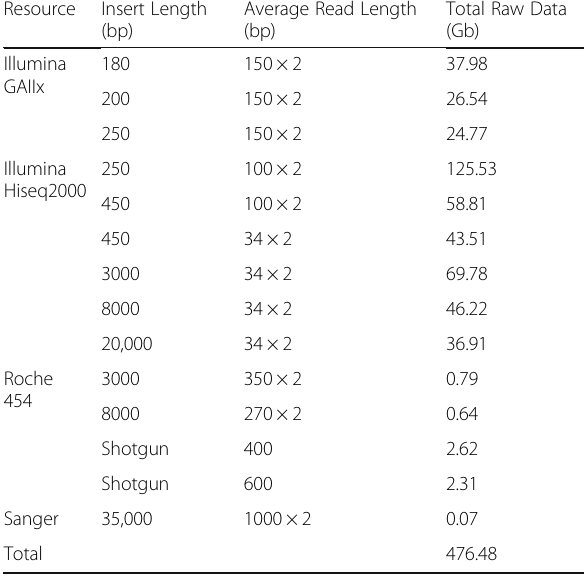
Total Raw Data (Gb)